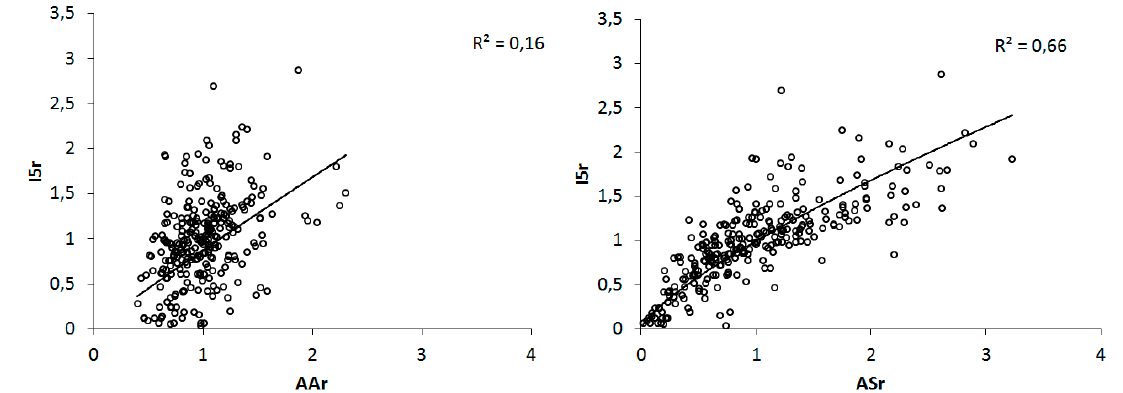
Figure 5. Relative 5-year radial increment (I5 r ) versus the relative spatially-available area of the tree (AA r ) and relative tree social area (AS r ).